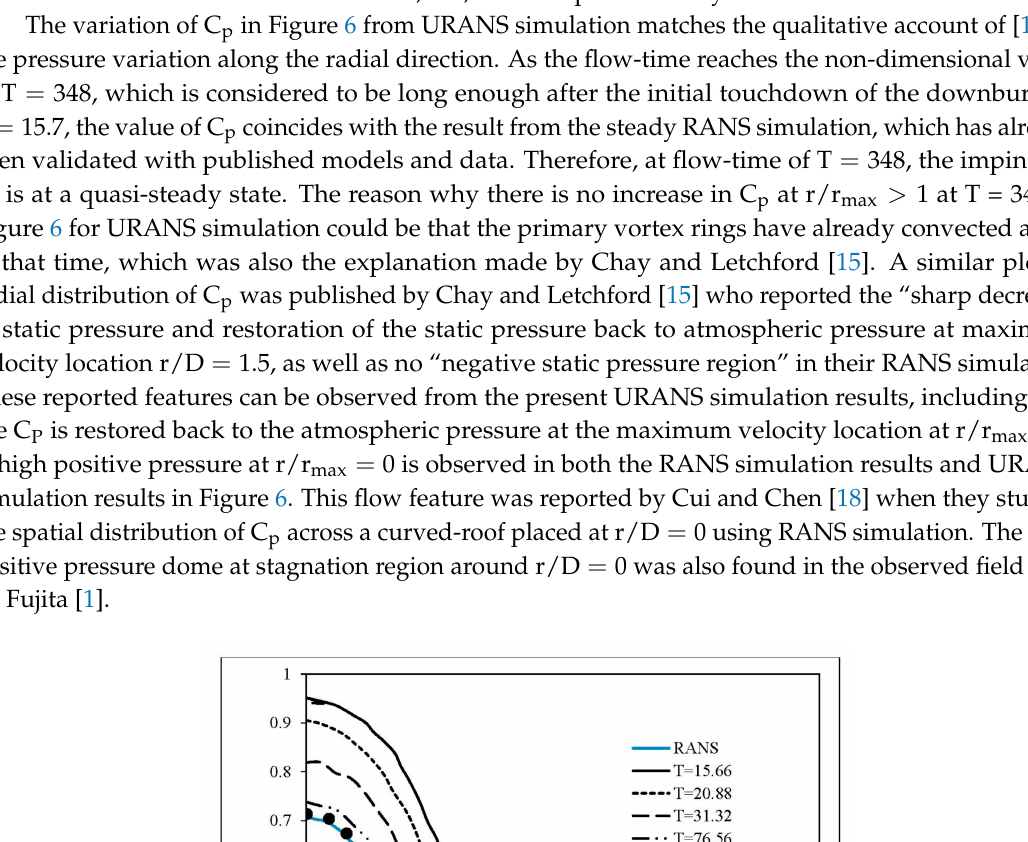
/D = 0.032 for the case of H/D = 4 at peak